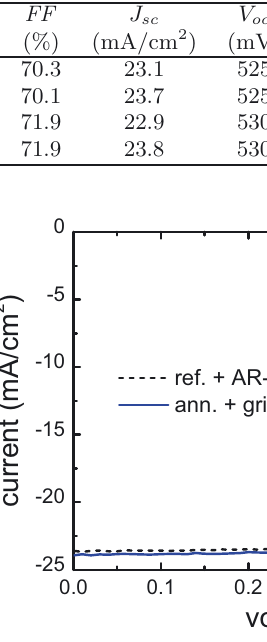
Fig. 5. J - V curves of 1- µ m-thick µ c-Si:H solar cells deposited on a reference ZnO:Al layer and on a ZnO:Al layer annealed at 600 ◦ C for 3.5 h equipped with Ag fingers. The width of the fingers is approximately 100 µ m and the density is 3 fingers per cm. Both cells are covered with an AR-RR